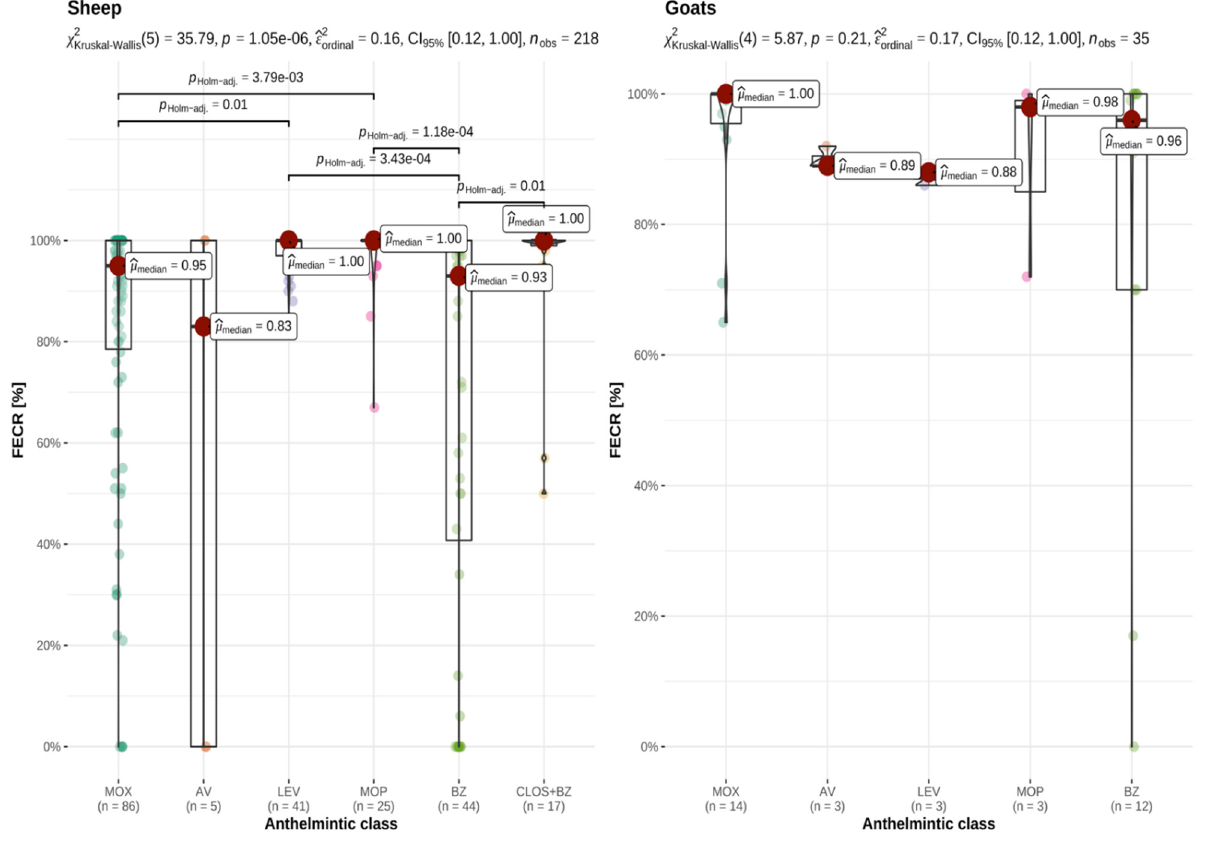
Figure 1. Faecal egg count reduction (FECR) following 253 anthelmintic treatments (sheep: 218; goats: 35) performed in 223 small ruminant flocks (sheep: 193; goats: 30), and paired com- parison between anthelmintic categories. n = number of flocks using anthelmintic category;